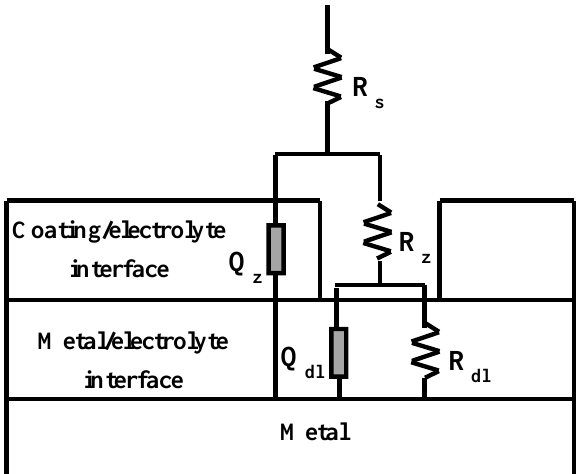
Figure 5. The electrical equivalent circuit (EEC) fitted to the experimentally obtained impedance data of the zeolite coated AZ91D alloy.